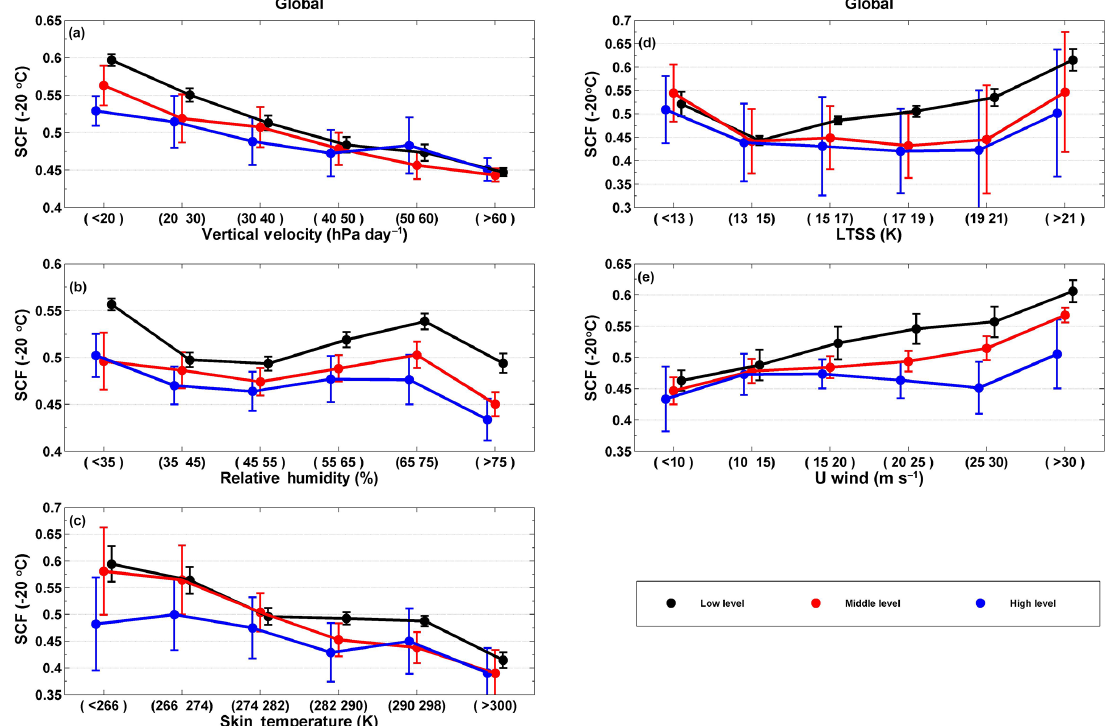
Figure 11. Spatial correlations between SCFs at − 20 ◦ C isotherm and meteorological parameters under different aerosol loading conditions. Only those regions with temporal correlations between SCFs and meteorological parameters at the 90% confidence level are used to calculate the spatial correlations between SCFs and meteorological parameters. The correlation coefficients are provided in Table